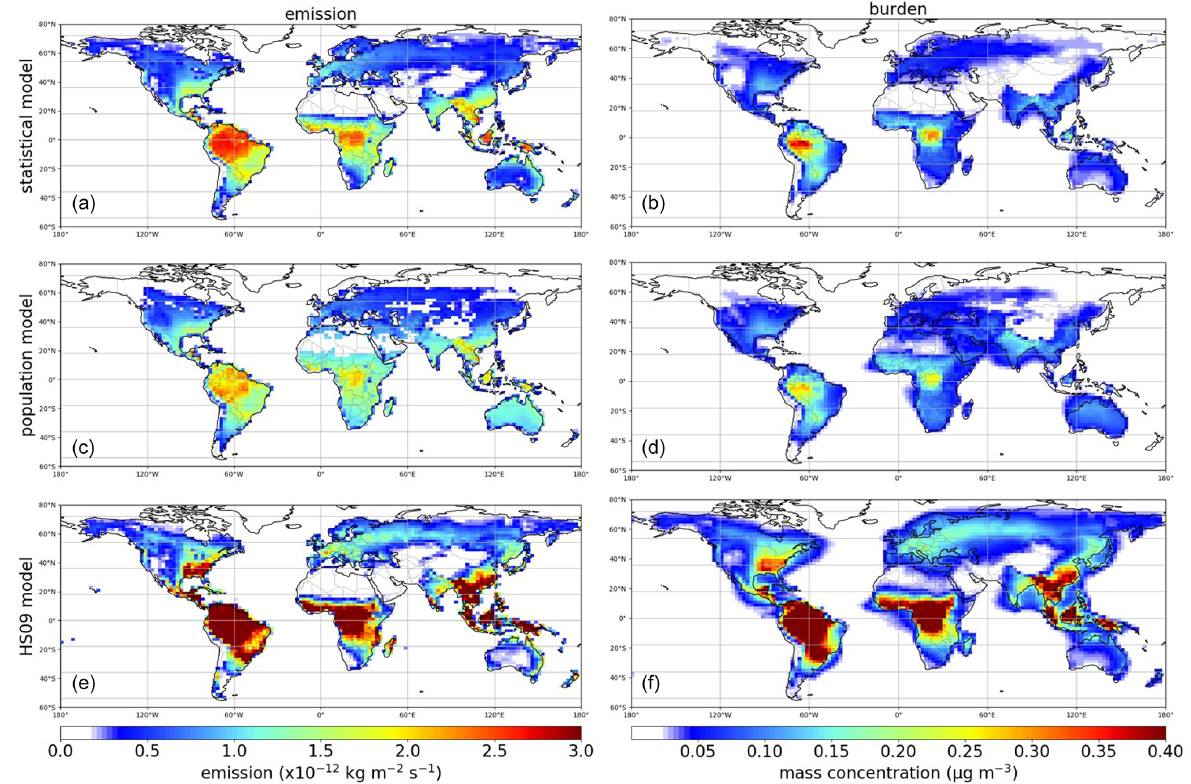
Figure 6. Annual average fungal spore emissions and mass concentration from the statistical (a, b) , the population (c, d) and the HS09 model (e, f)